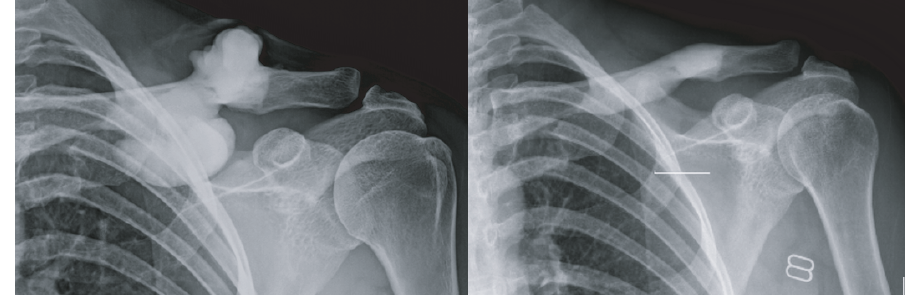
Figure 1 : Left shoulder radiographs showing osteodense solid homogenous mass around the mid-clavicula in preoperative imaging (a) and postoperative imaging (b).